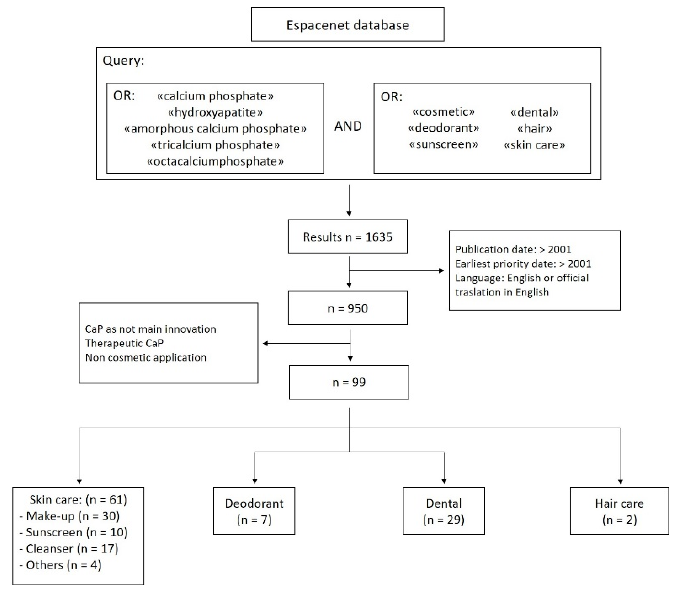
Figure 4. Flowchart of the patent search and refinement.